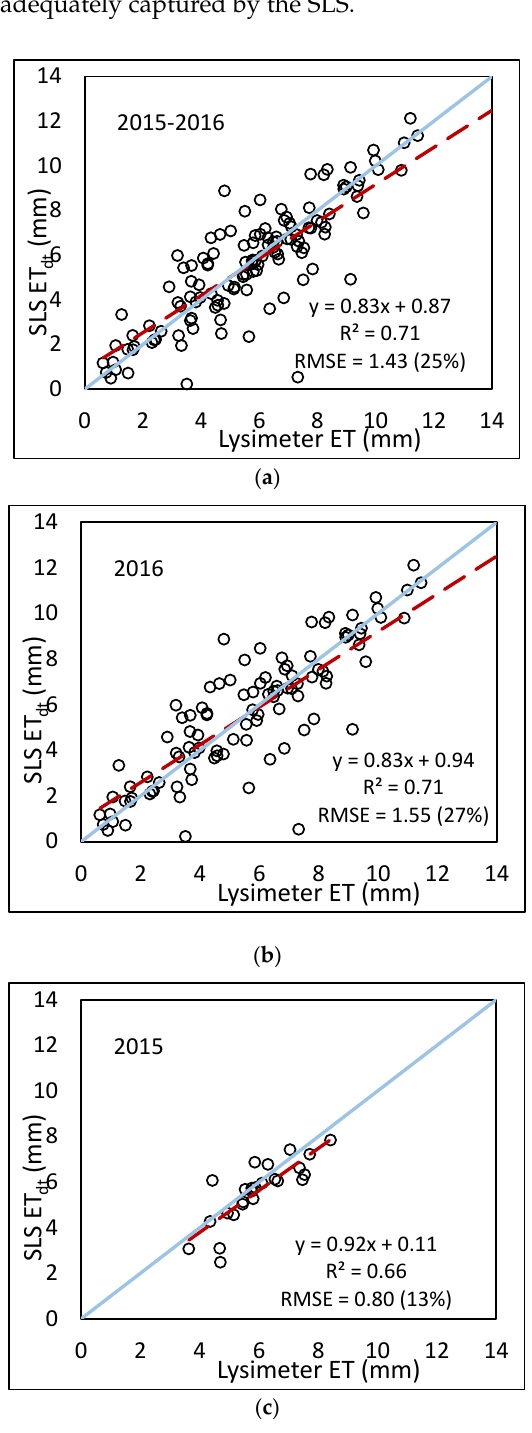
Figure 12. Comparison of summed daily ET from the SLS to daily (mass change from midnight to midnight) lysimeter data using ( a ) combined 2015–2016 data; ( b ) 2016 only; ( c ) 2015